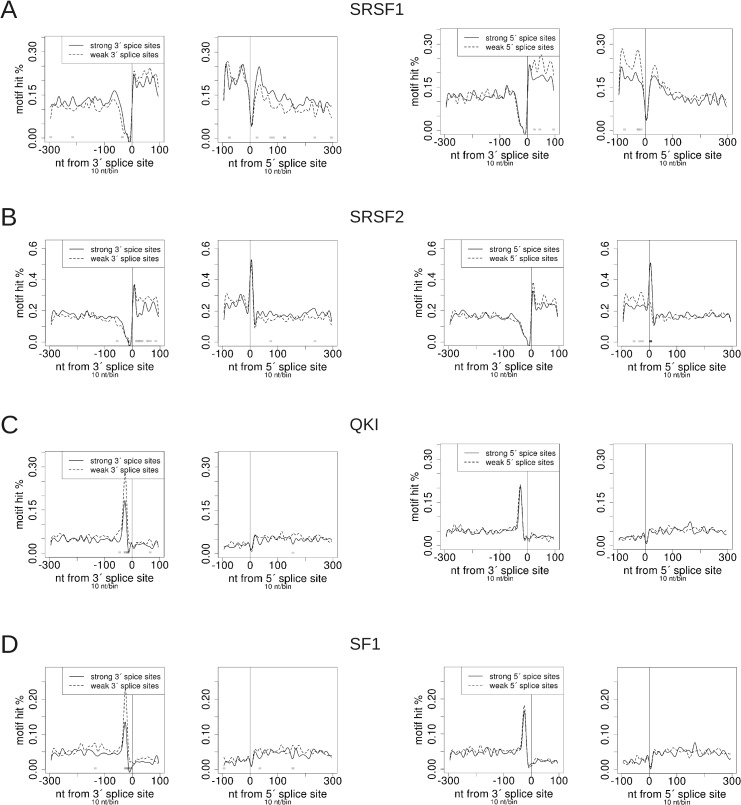
RBP motif validation profiles.“Strong” and “weak” are the upper and lower quartiles of splice site strength, respectively. Only exons longer than 100nt are considered. The corresponding profiles for the full internal exon set are in S1 File. Test vs. control P-values/bin are as shown in Fig 1B, with the lightest shade of grey corresponding to P-value < 0.01.